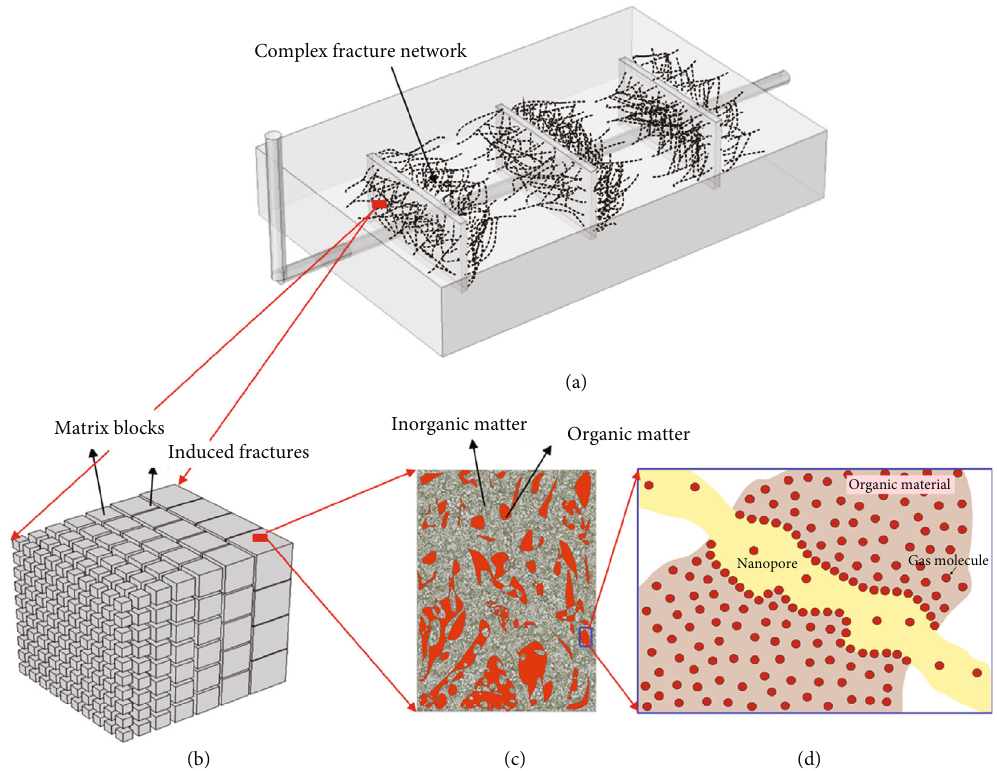
Figure 6: Heterogeneous discrete fractures coupled with dual media of organic and inorganic matter in shale gas